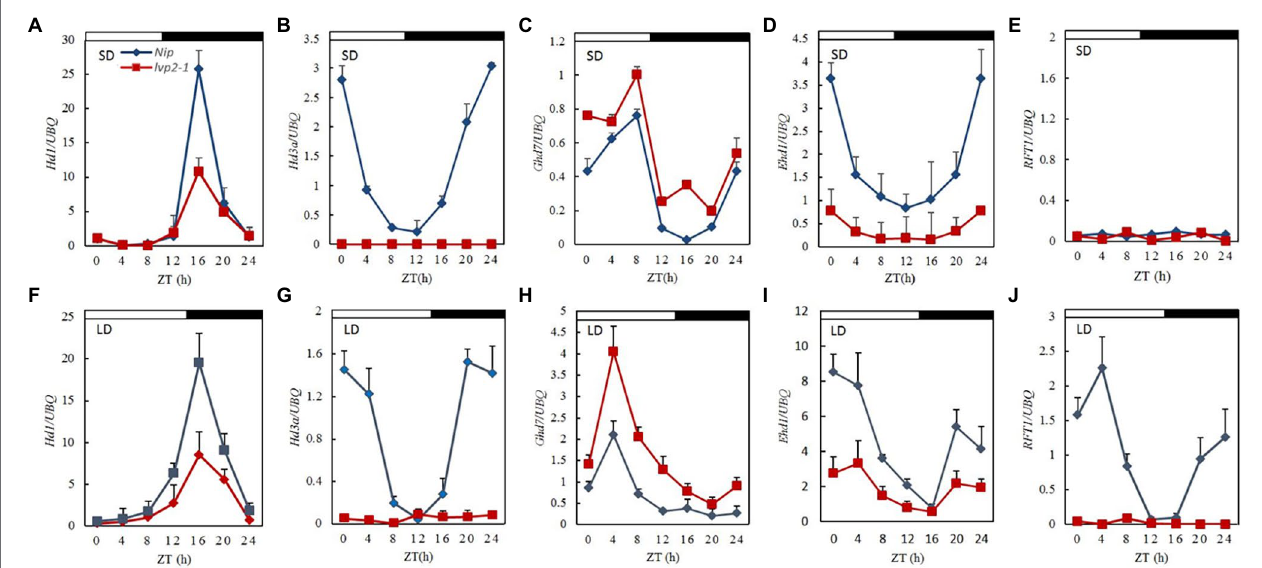
FIGURE 5 | Diurnal expression of photoperiodic flowering pathway genes in lvp2-1 mutant under both SD and LD conditions. Diurnal expression patterns of Hd1 (A,F) , Hd3a (B,G) , Ghd7 (C,H) , Ehd1 (D,I) and RFT1 (E,J) in Nipponbare (blue diamonds) and lvp2-1 (red squares) plants under LD (14 h light) and SD (10 h light) detected by qRT-PCR analysis. Rice leaves were collected at the indicated time points from 35- and 70-day-old plants grown under SD and LD conditions, respectively. The expression levels are relative to the UBQ mRNA. Values and error bars are the mean and SD of three replicates. The white bars and black bars at the top represent the light and dark periods, respectively. ZT means Zeitgeber